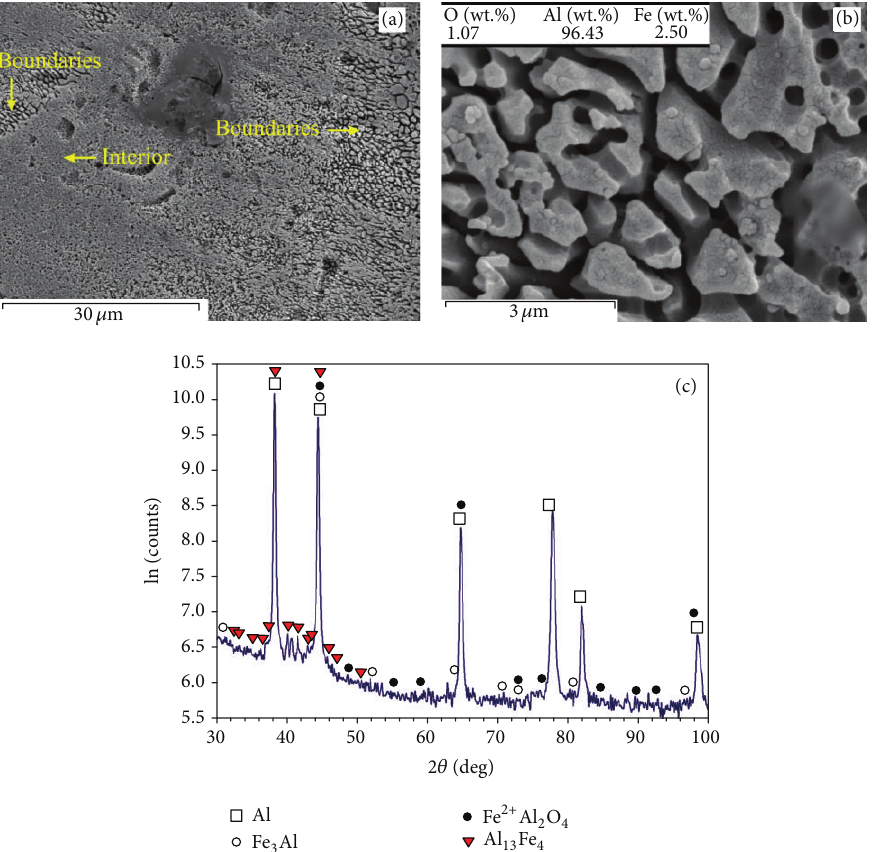
Figure 5: (a) Overall view of microstructure, (b) boundaries seen in the previous image, and (c) XRD pattern of the part fabricated when 𝑃 = 39 W, V = 0.14 m/s, and 𝑡 = 75𝜇 m. Table 1: Summary of microstructural evolution in the dependence of layer thickness, laser power, and scanning speed. Thick powder bed 𝑡 = 75 𝜇 m 𝑡 = 50𝜇